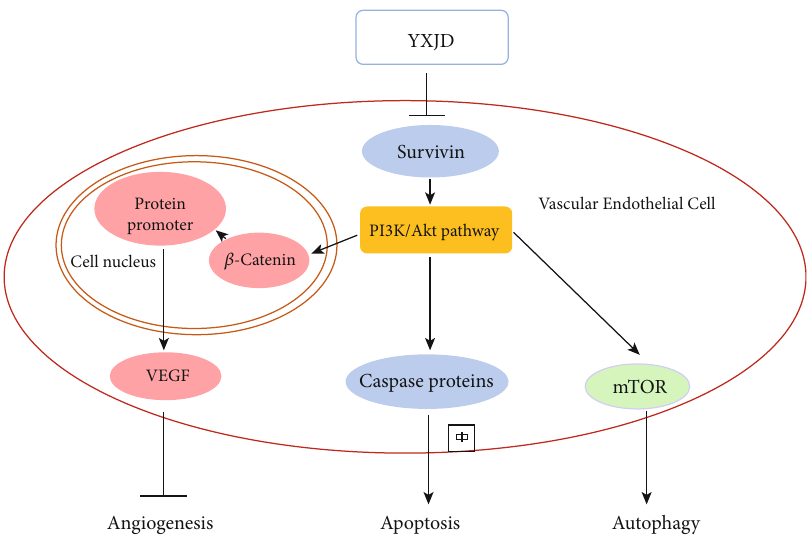
Figure 9: YXJD regulated vascular regression via Survivin/PI3K/Akt pathway in morbigenous signal